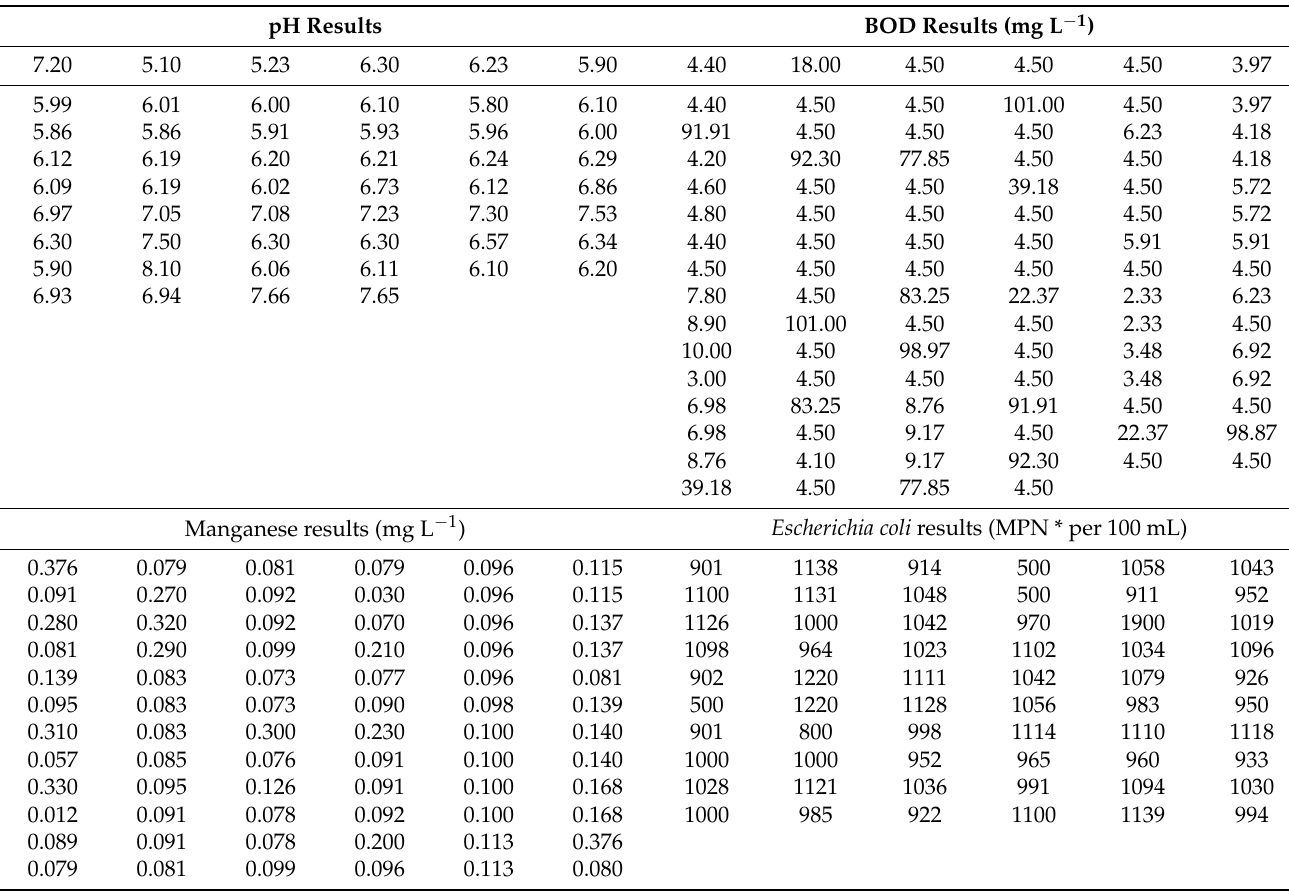
Table 1. Raw data of some biochemical properties of the Maca é River collected in